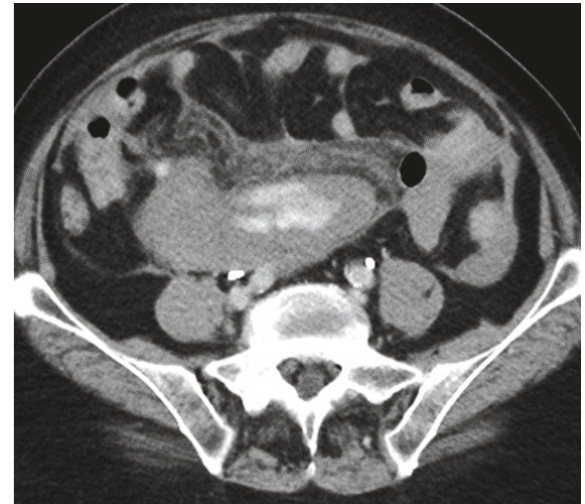
Figure 1: CT abdomen and pelvis without contrast showing hypo- dense area of bleeding. Figure 2: CTA abdomen showing hyperdense area of